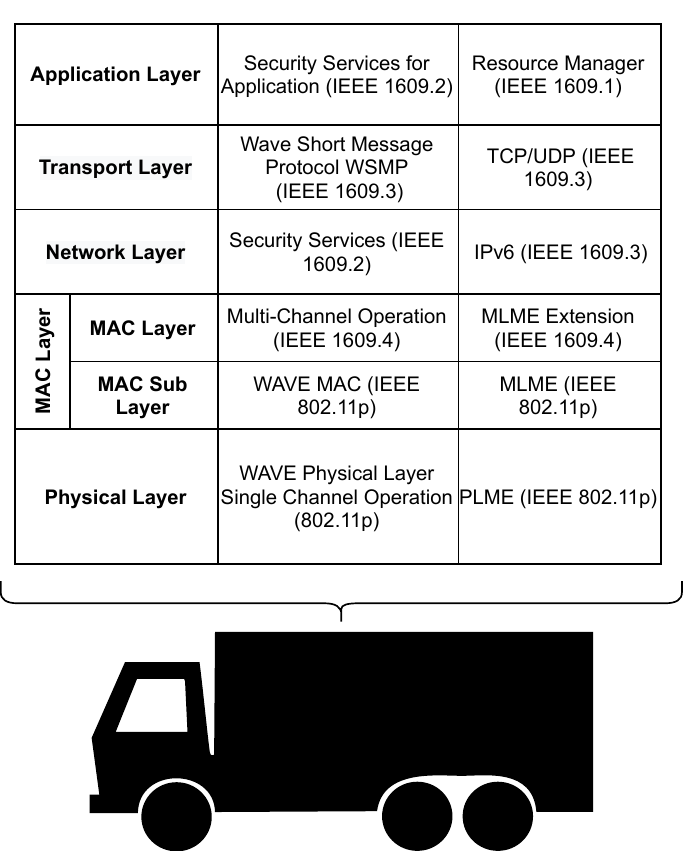
Figure 10. WAVE network